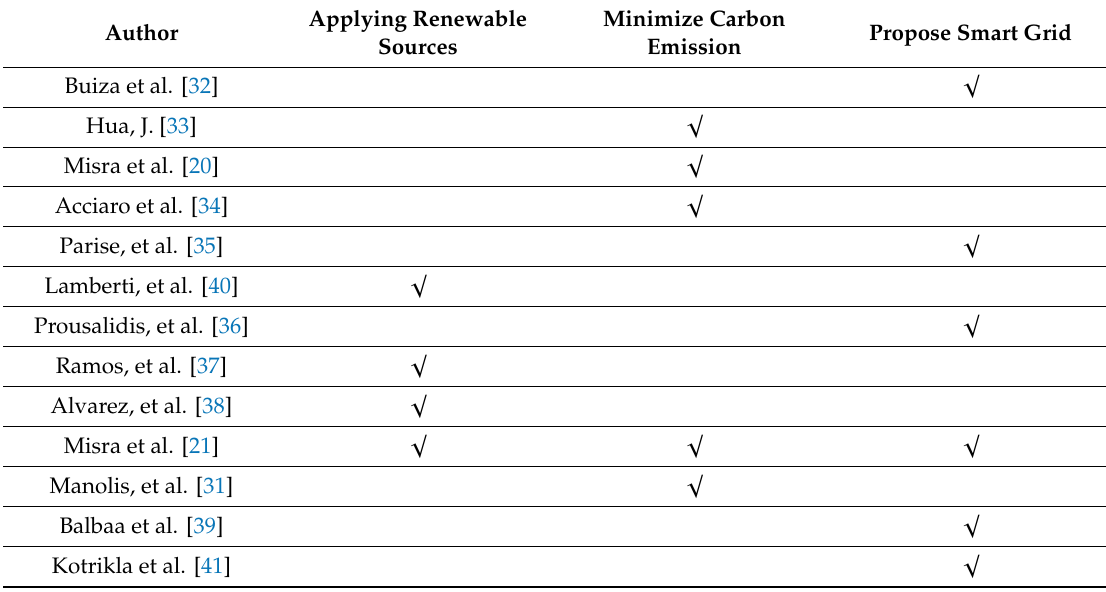
Table 1. Related